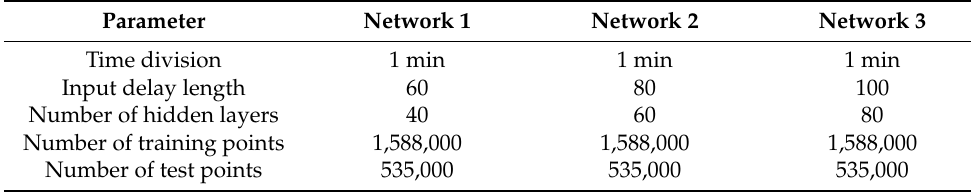
Table 15. Network configuration